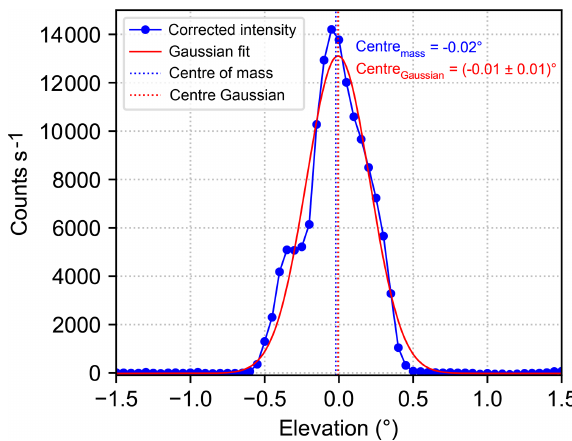
Figure 10. Background-corrected intensity curve at 440nm and corresponding Gaussian fit for the white-stripe scan on 20 Septem- ber performed by the MPIC instrument. The retrieved apparent stripe positions for the two methods are indicated by the dashed lines.